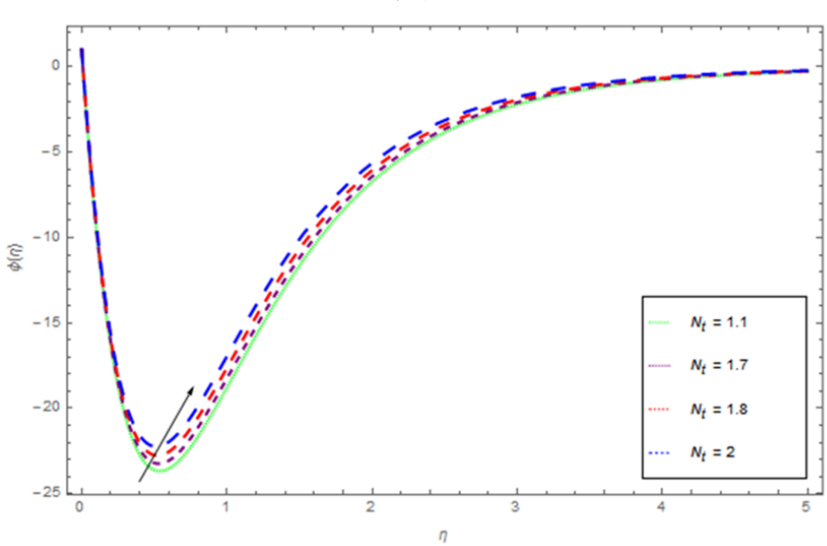
Figure 12. The influence of N b on φ ( η ) when γ = 0.4, N t = 0.5, Sc = 0.6.